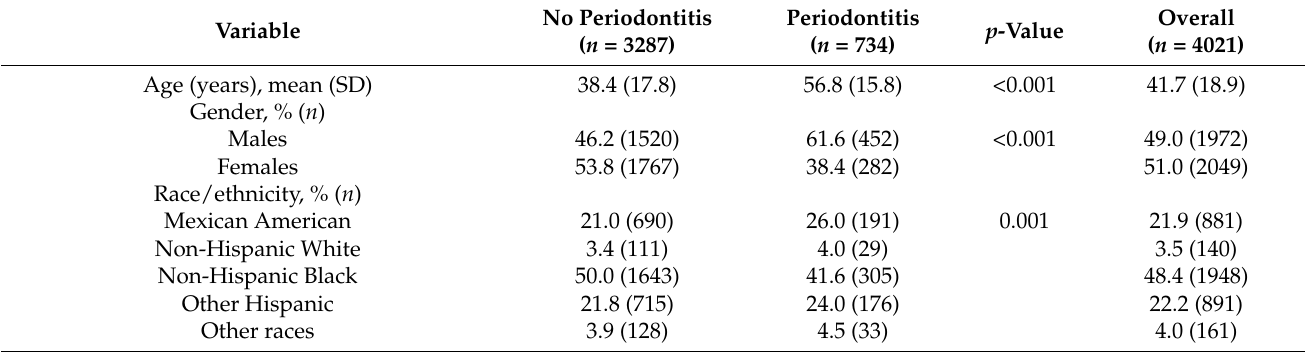
Table 1. Sample characteristics according to periodontal status ( n =